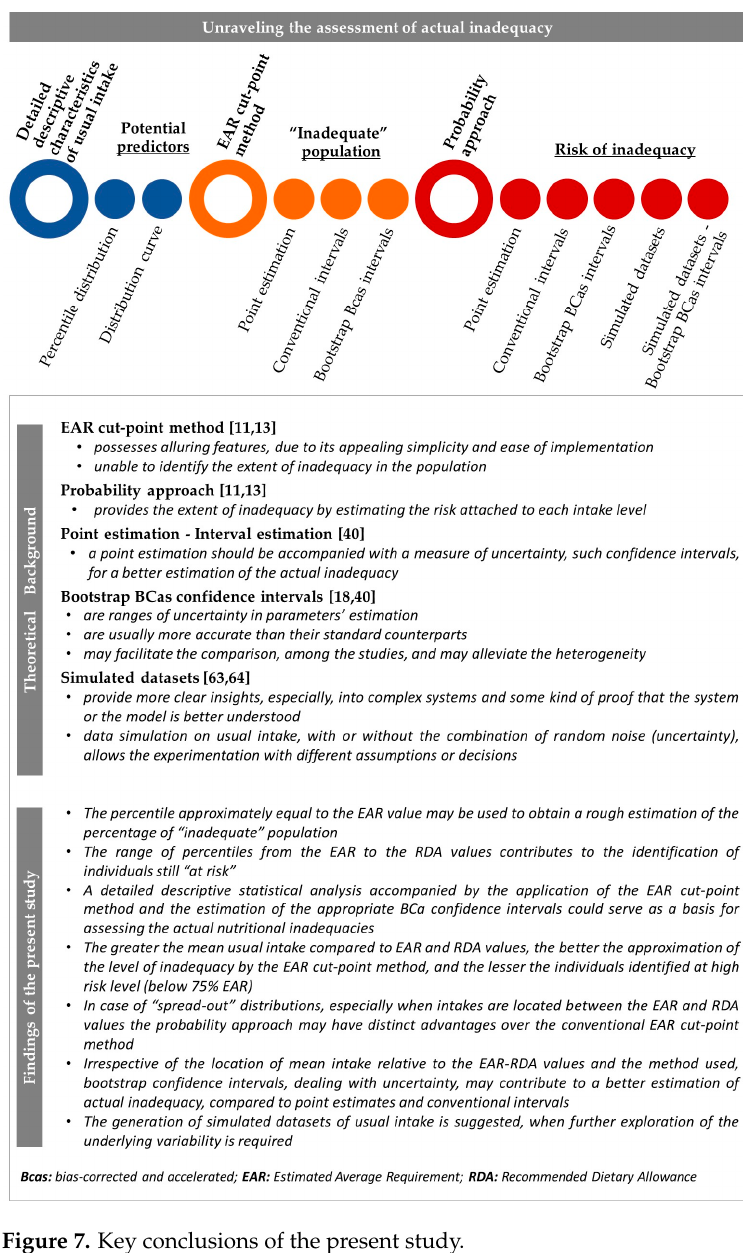
Figure 7. Key conclusions of the present study.